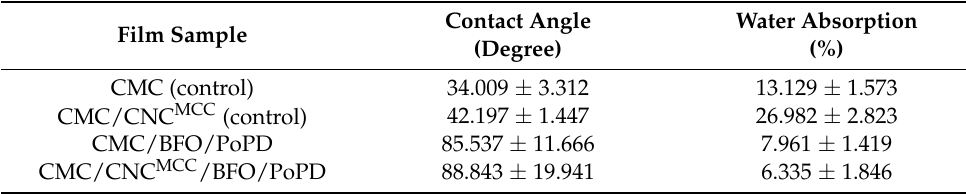
Table 3. Contact angle (CA), and water absorption of film